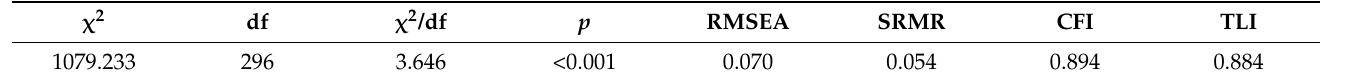
Figure 1. The three-factors model of the college students’ involution. Table 4. Confirmatory Factor Analysis Model Fit Indices.